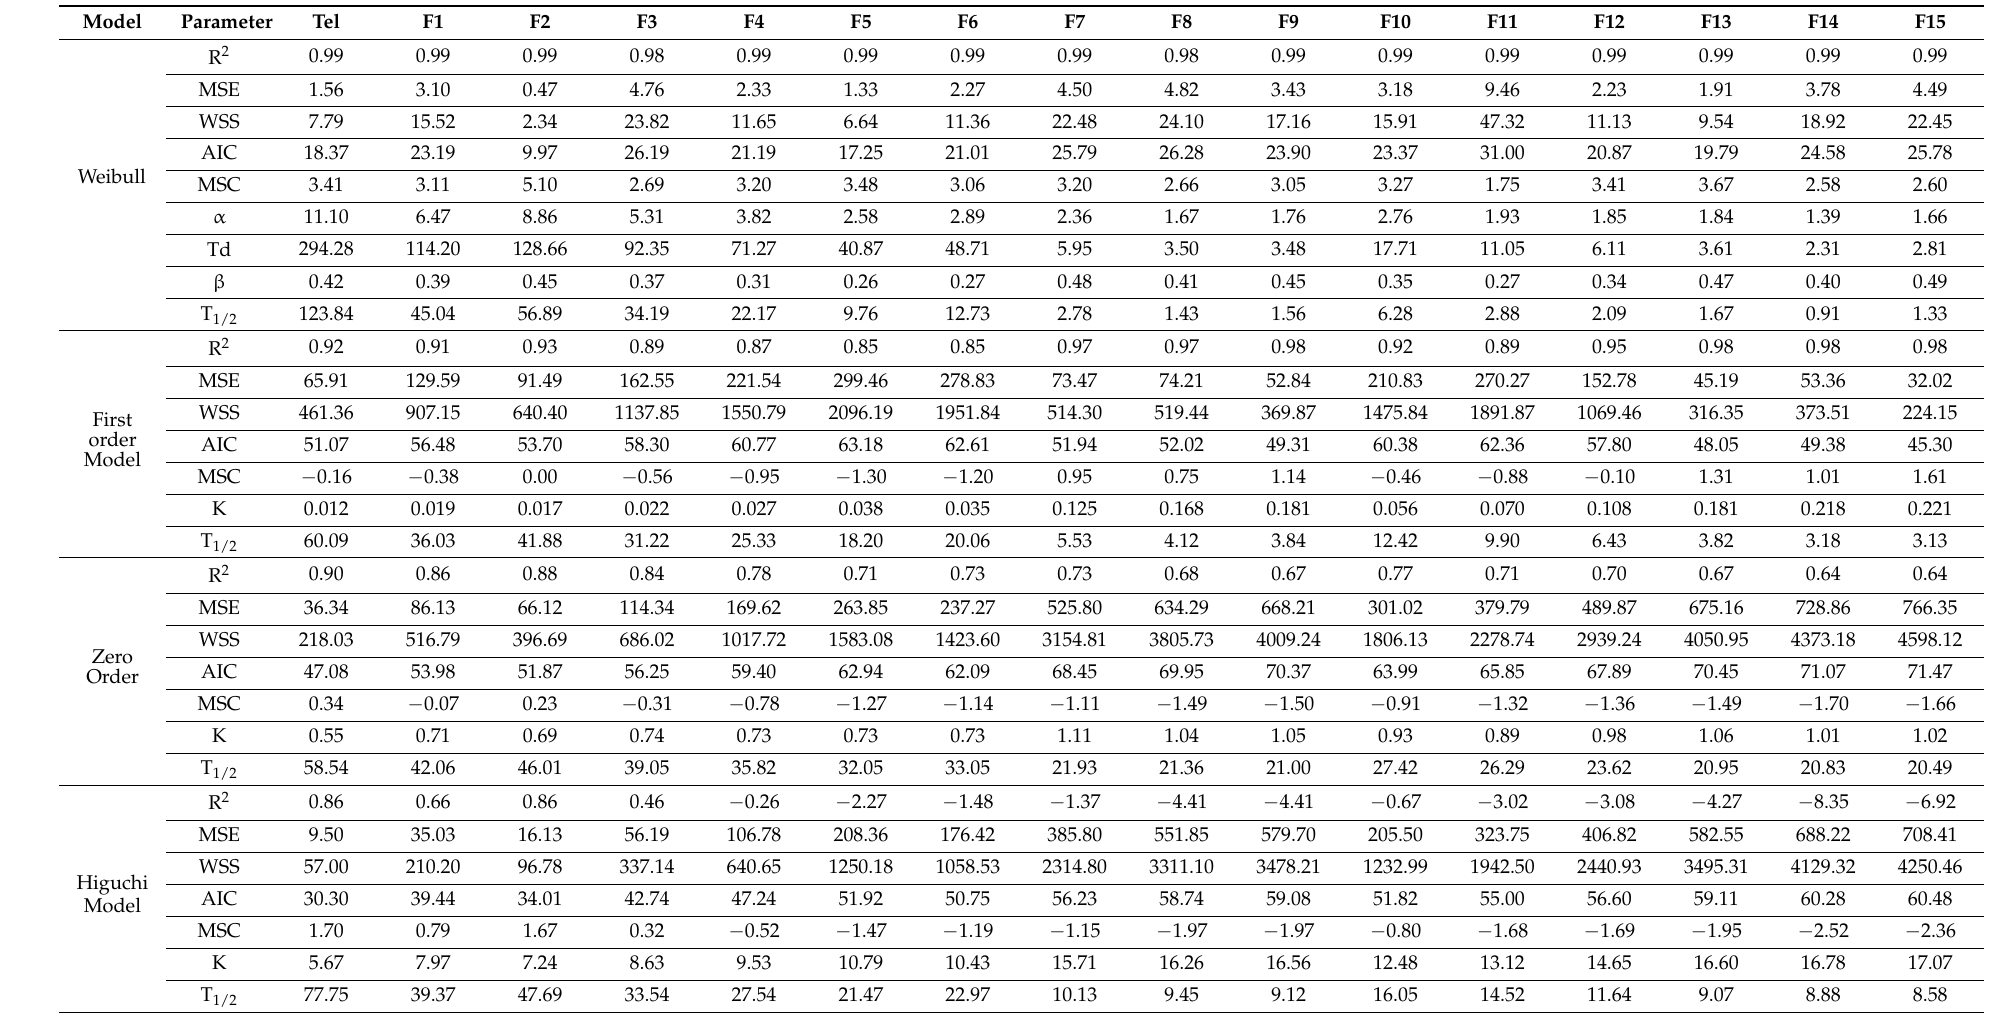
Table 3. Kinetic model selection criteria and models